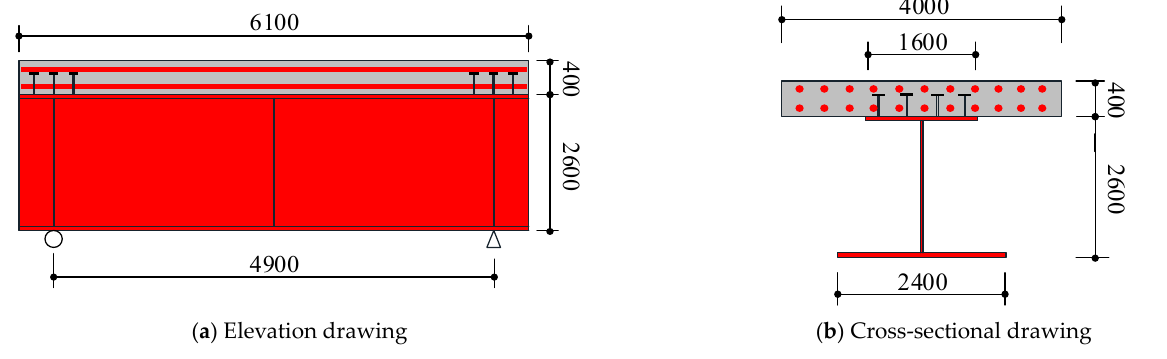
Figure 2. Elevation and cross-section diagrams of the composite beams (unit: mm).